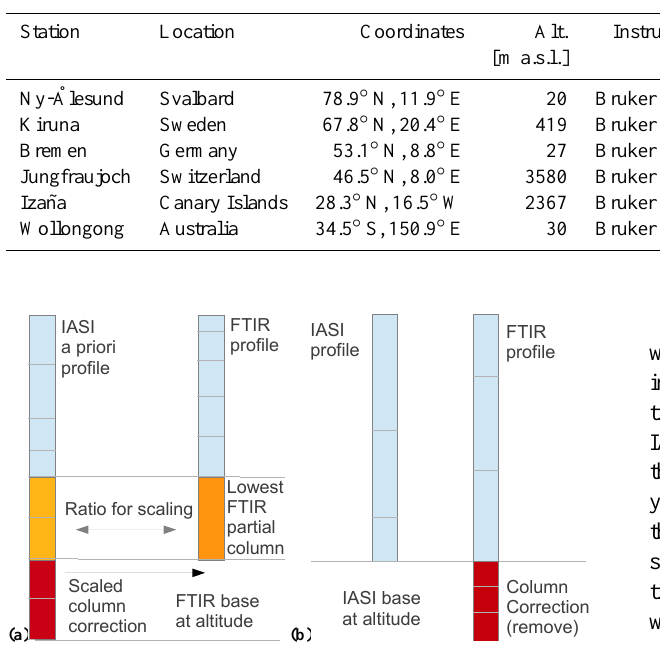
Table 1. List of the FTIR stations that provided data for the analyses (Sect. 5). The latitude and longitude of each station are provided, together with the altitude above sea level in meters (ma.s.l.). The instrument, the maximum optical path difference (maxOPD) and the retrieval code (+version) used for the CO measurements are indicated for each station in columns 5, 6 and 7. References describing the stations, measurements and analyses are given in column 8.